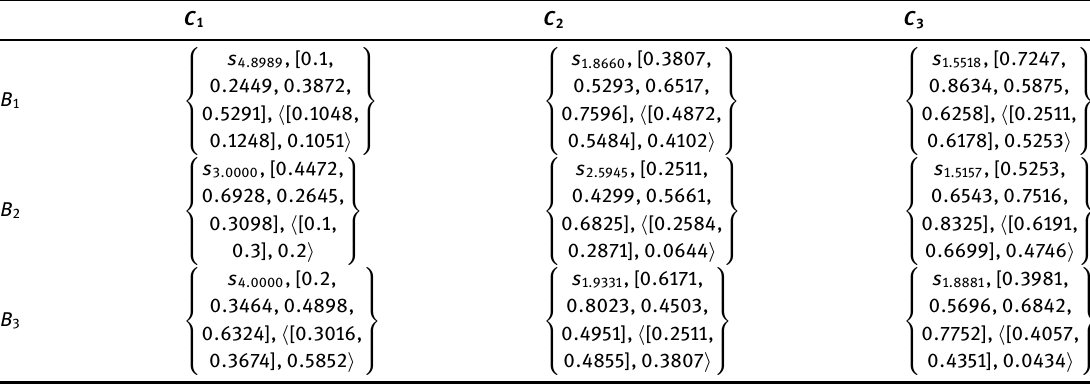
Step 2: Construct a normalized trapezoidal linguistic cubic fuzzy TOPSIS decision matrix R = [ β normalized value β is calculated as (Table 4): ij Step 3 : Make the weighted normalized trapezoidal linguistic cubic fuzzy TOPSIS decision matrix by multiply- ing the normalized trapezoidal linguistic cubic decision matrix by its associated weights. w 1 = 0.3721, w 2 = 0.3057, w 3 = 0.3221 (Table 5). Table 3: The Aggregated TrLCF-Decision Matrix. C 1 C 2 C